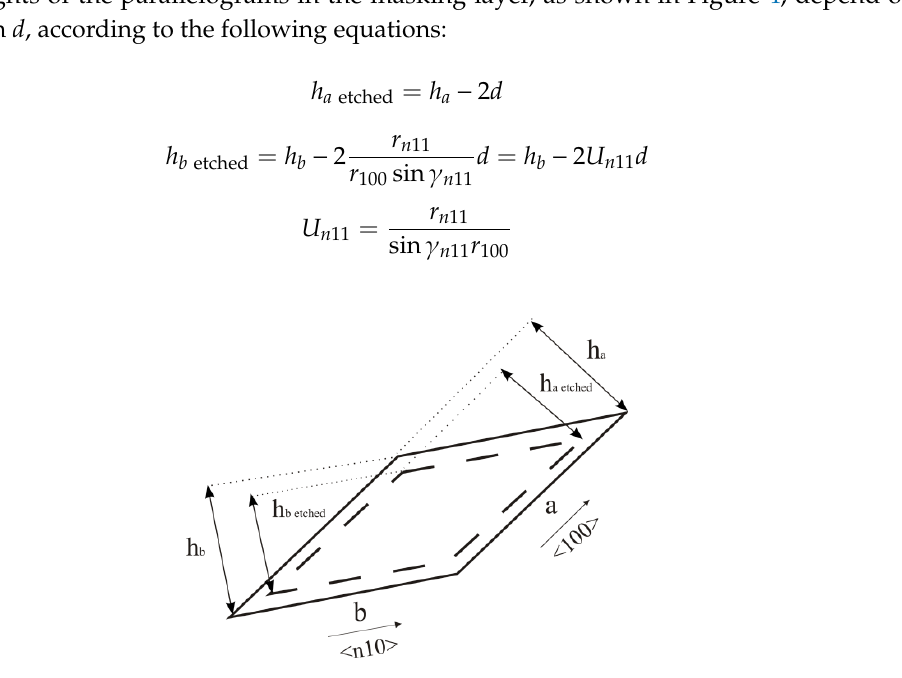
Figure 4. Schematic picture of the parallelogram heights h a and h b changing in the masking layer during etching. a and b are length of the sides of a parallelogram in the < 100 > and < n10 > crystallographic directions respectively.